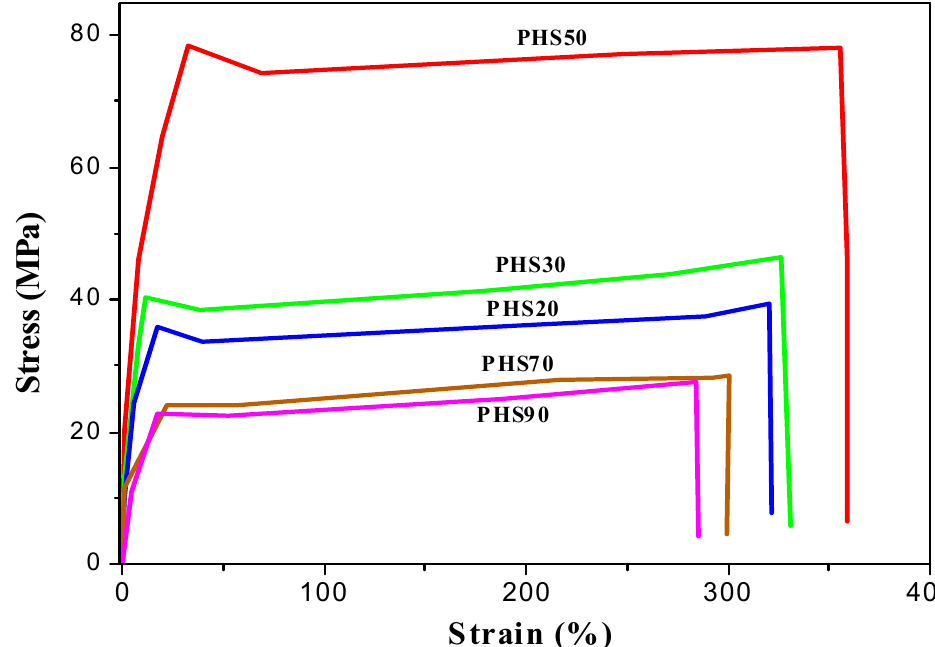
Figure 7. Tensile testing of synthesized copolyesters PHS(20–90). Table 5. Comparison of the tensile properties of copolyesters PHS(20–90) and commercial polymers.